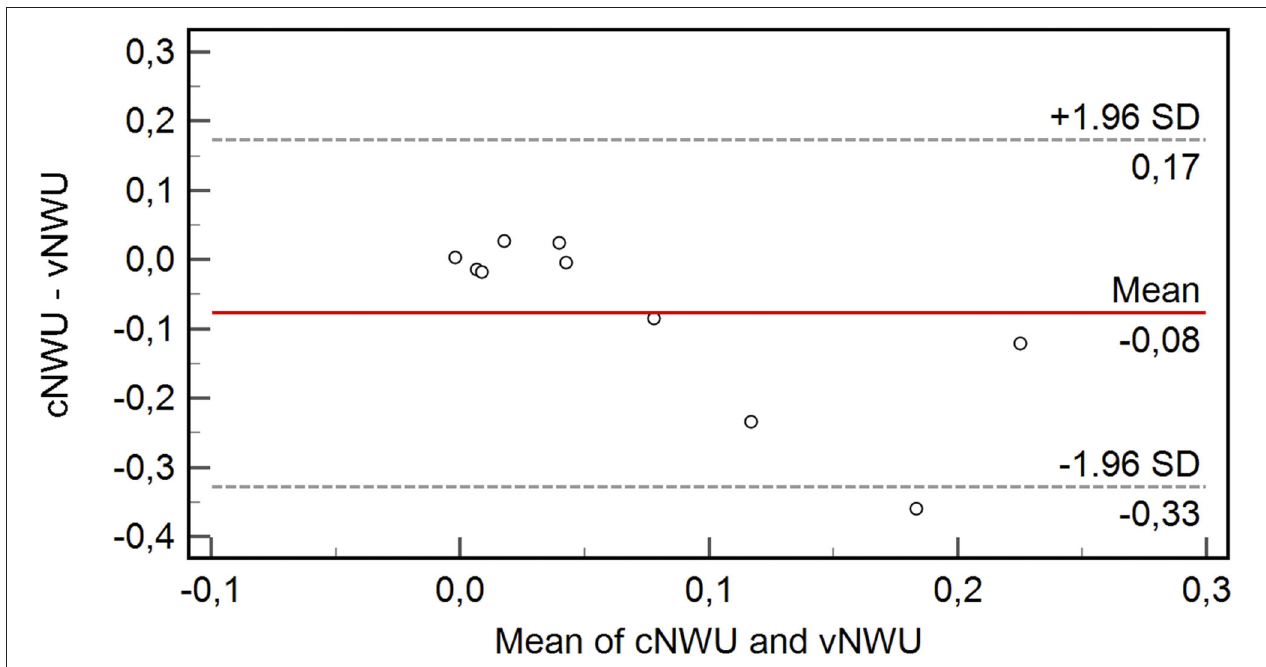
FIGURE 2 | Bland-Altman Plot showing the variable difference of cNWU and vNWU in percent. The mean difference between both methods was − 0.08 with only one patient outside ± 1.96 standard deviations.